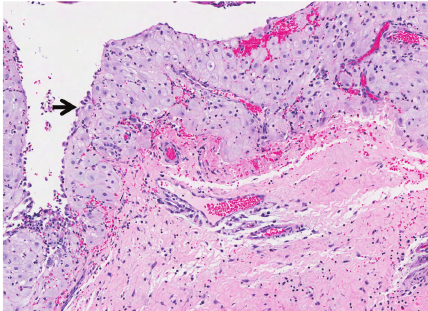
Figure 13: Endometriosis with decidualization: medium power magnification showing cystic space surrounded by large polygonal cells with basophilic cytoplasm and bland nuclei. The cyst wall is rimmed by a layer of endometrial cells (arrow). (H&E, ×